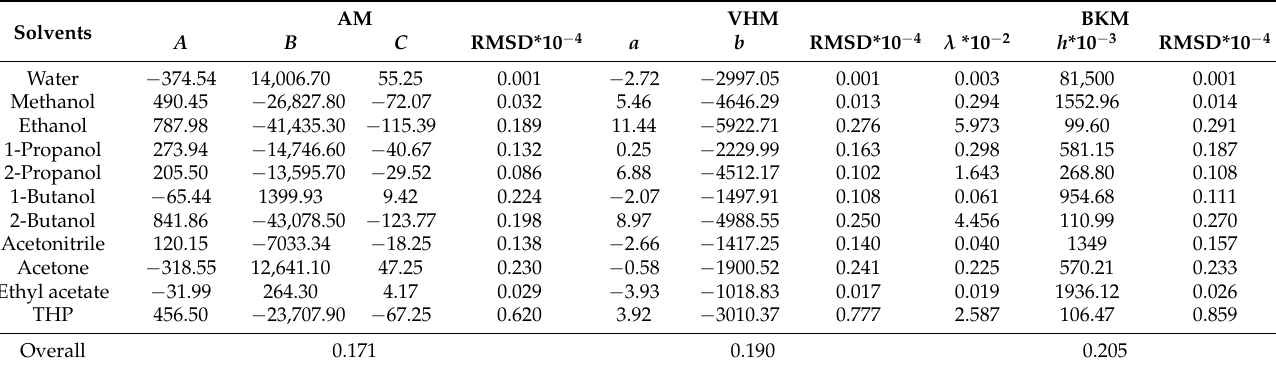
Table 1. Parameters of the modified Apelblat model (AM) equation, van’t Hoff model (VHM) equation and Buchowski– Ksiazaczak λ h model (BKM) equation for ABN401 in organic solvents and their respective relative mean standard deviation (RMSD) values.